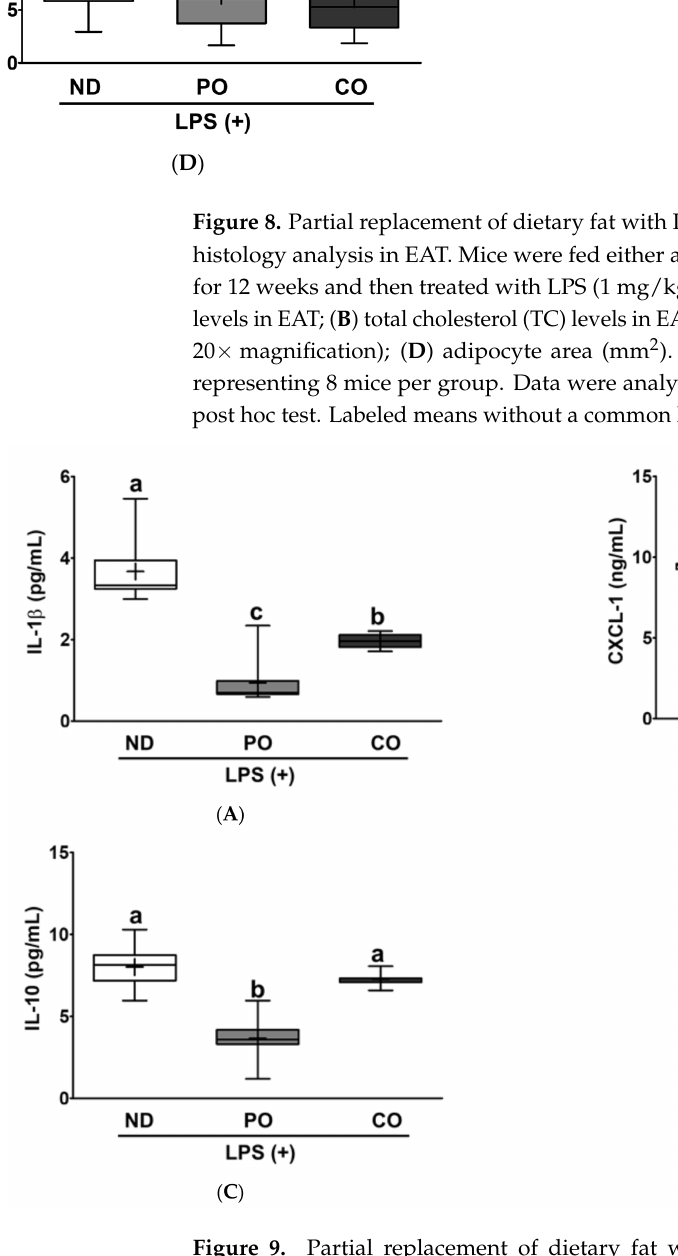
Figure 9. Partial replacement of dietary fat with PO or CO and LPS challenge on pro/anti- inflammatory cytokines, chemokine in EAT. Mice were fed either an ND or an ND partially replaced with PO or CO for 12 weeks and then treated with LPS (1 mg/kg) for 24 h ( n = 8 per group). ( A ) Interleukin (IL)-1 β levels; ( B ) C-X-C Motif Chemokine Ligand 1 (CXCL-1) levels; ( C ) IL-10 levels. Values are presented as box and whisker plots representing 8 mice per group. Data were analyzed using one-way ANOVA followed by Tukey’s post hoc test. Labeled means without a common letter differ ( p < 0.05).